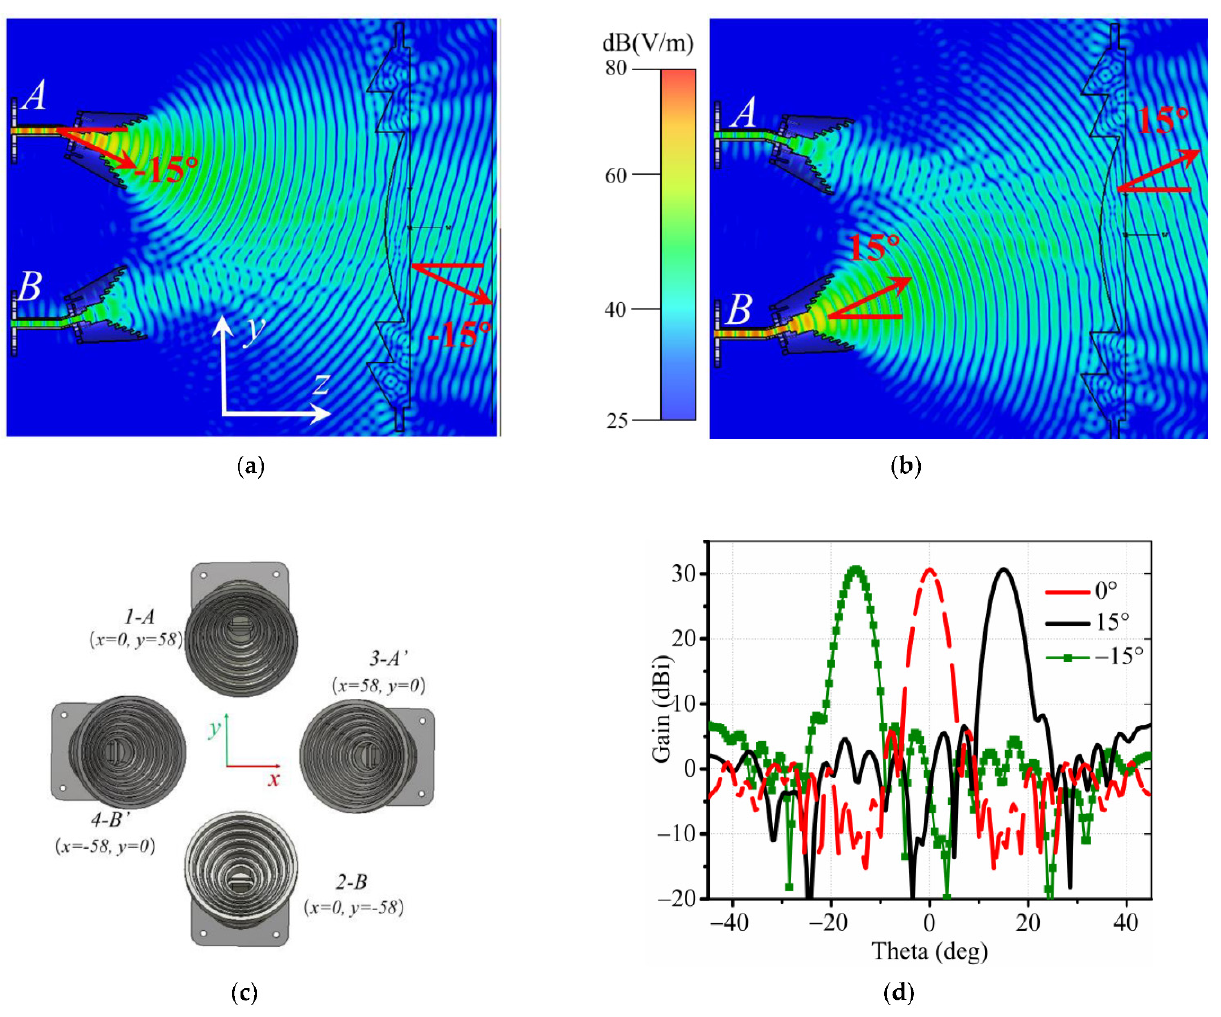
Figure 5. E- field distribution of the dielectric lens in the yoz plane at 24 GHz with ( a ) − 15 deg, ( b ) 15 deg, ( c ) the 2 × 2 horn array in the xoy plane, and ( d ) radiation patterns.